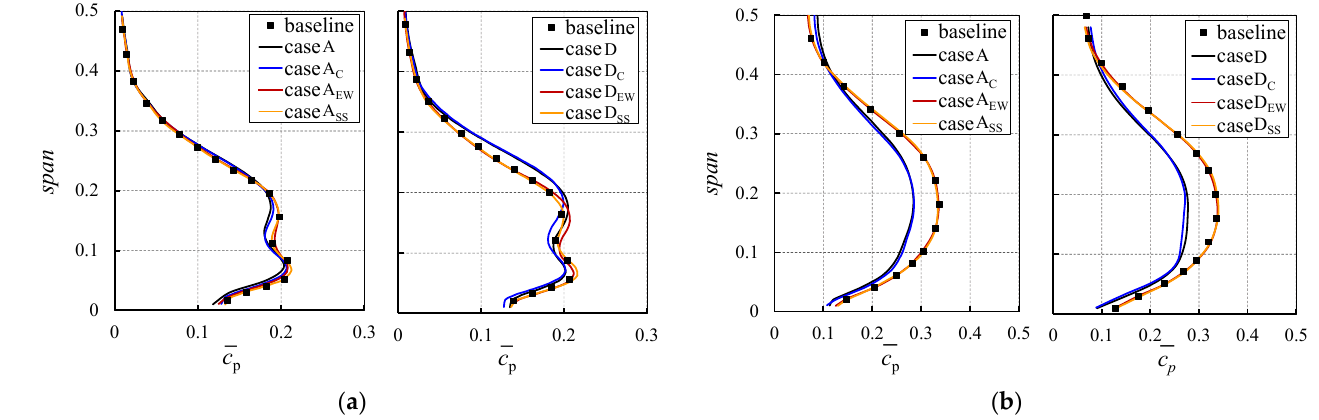
Figure 11. Pitch-averaged total pressure loss at 0.4 C a downstream of the TE. ( a ) At the design point ( i = −1°); ( b ) near-stall point ( i = 7°).